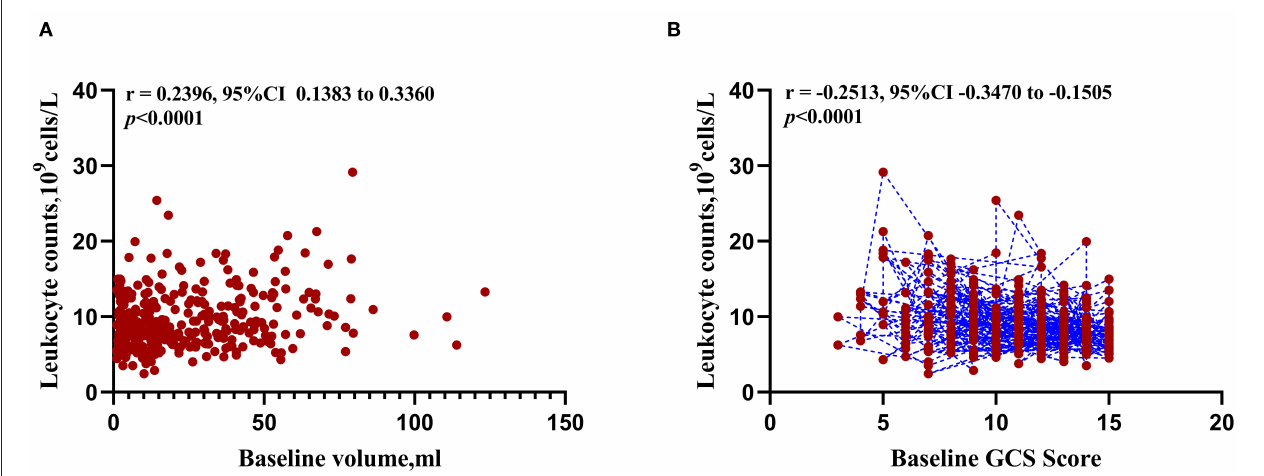
FIGURE 3 | Correlation between peripheral blood leukocyte counts and initial clinical status at admission. (A) Scatterplot of expression correlation between leukocyte counts and baseline volume. (B) Scatterplot of expression correlation between leukocyte counts and baseline Glasgow Coma Scale score.